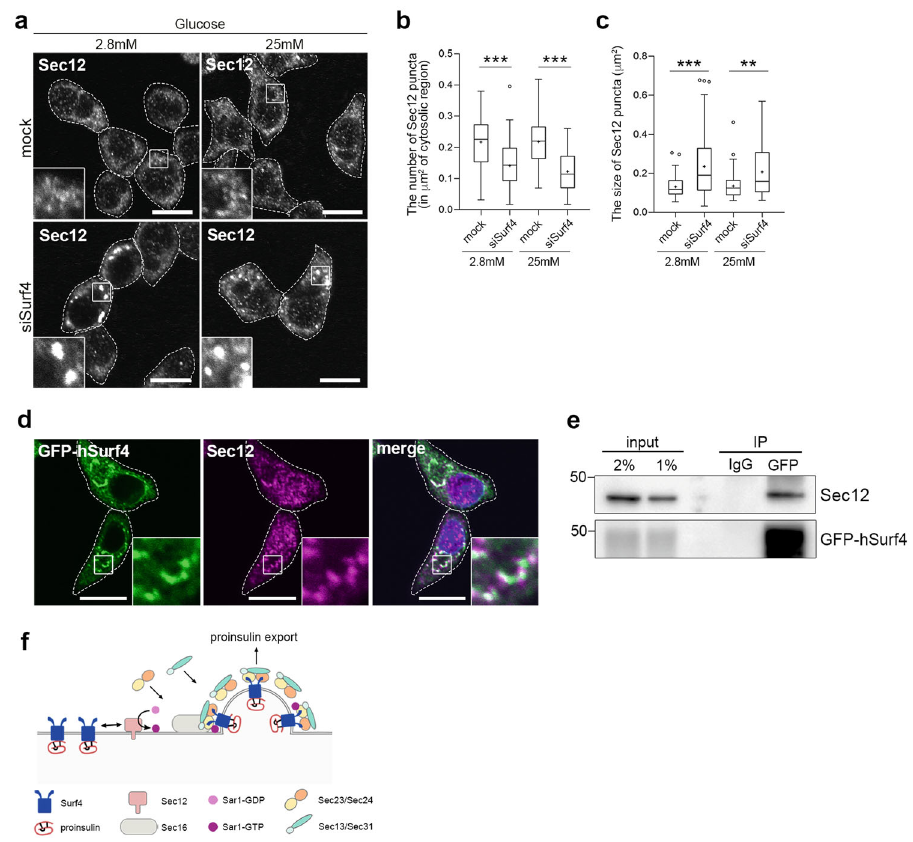
Fig. 7 Surf4 physically interacts with Sec12 and affects its localization. a INS-1 832/13 cells were transfected with the control (mock) or Surf4 siRNA(siSurf4) and incubated in KRB containing low (2.8 mM) or high (25 mM) glucose for 2 h. Cells were fi xed and stained with an anti-Sec12 antibody. Dotted lines indicate cell outlines. Scale bars: 10 µ m. b , c The number and size of Sec12-positive punctate structures in the cytoplasm were measured ( n = 86, mock-transfected cells at low-glucose conditions; n = 83, siSurf4-transfected cells at low-glucose conditions; n = 73, mock-transfected cells at high-glucose conditions; n = 71, siSurf4-transfected cells at high-glucose conditions). Data are presented as the box and whisker plots, and analyzed by two-tailed Mann – Whitney U tests, ** p < 0.05; *** p < 0.01. d INS-1 832/13 cells expressing GFP-hSurf4 were immunostained with an anti-Sec12 antibody. GFP-Surf4 partially colocalizes with Sec12. Dotted lines indicate cell outlines. Scale bars: 10 µ m. e GFP-hSurf4 physically interacts with Sec12. INS- 1 832/13 cells expressing GFP-hSurf4 were immunoprecipitated with an anti-GFP antibody. Total lysates (input, 2 and 1%) and Immunoprecipitates (IP) were immunoblotted with anti-Secl2 and anti-GFP antibodies. f Schematic of the proposed function of Surf4 in the ER export of